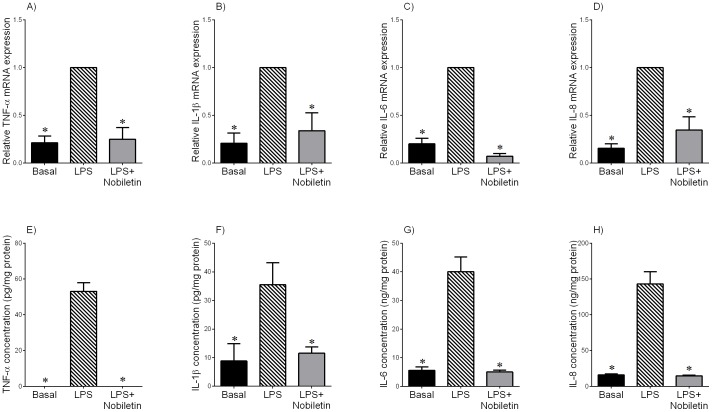
Effect of nobiletin on LPS-induced cytokine expression and release in term fetal membranes.Fetal membranes were incubated with or without 10 µg/mL of LPS in the absence or presence 200 µM of nobiletin for 20 h (n = 6 patients per group). (A–D) TNF-α, IL-1β, IL-6 and IL-8 mRNA expression was analysed by qRT-PCR and normalised to GAPDH mRNA expression. The relative fold change was calculated relative to LPS and data presented as mean ± SEM. *P<0.05 vs. LPS (one-way ANOVA). (E–H) The incubation medium was assayed for concentration of TNF-α, IL-1β, IL-6 and IL-8 by enzyme immunoassay. Each bar represents mean concentration ± SEM. *P<0.05 vs. LPS (one-way ANOVA).